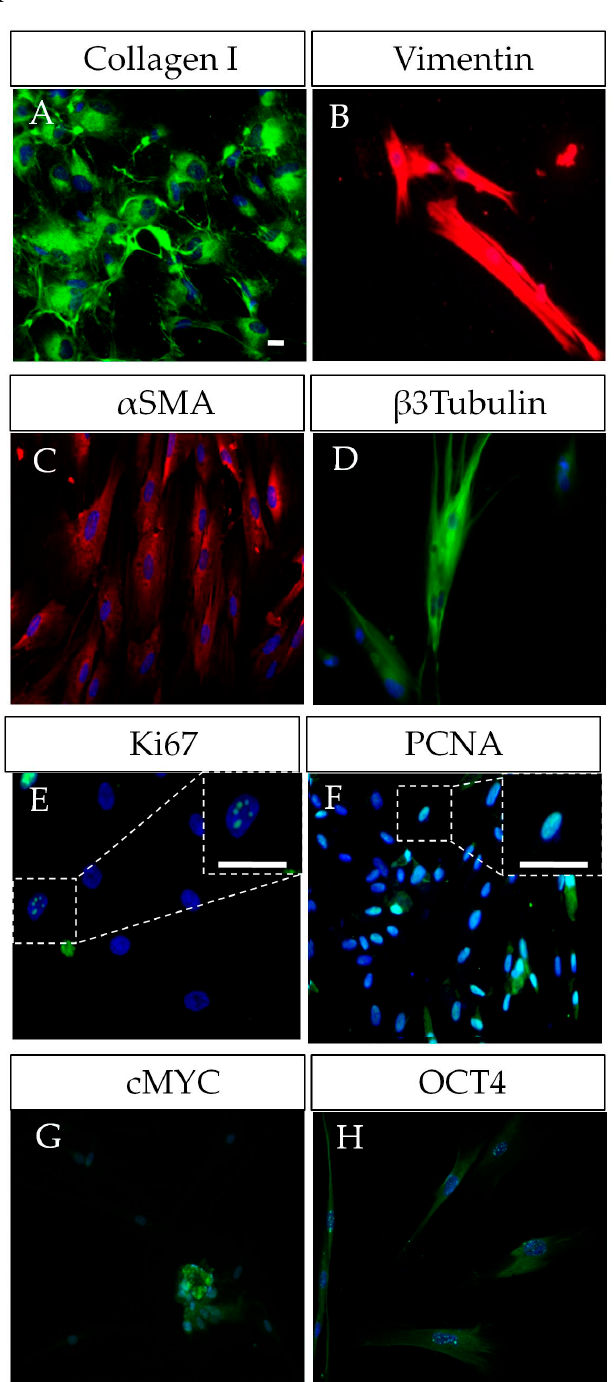
Figure 1. Characterization of human DPSCs in vitro. ( A – D ) DPSCs grown in plastic-adherent conditions show a co-expression of mesenchymal markers (COLLAGEN I, VIMENTIN, α -SMA) and neural markers ( β -III-TUBULIN/TUJ1, NESTIN), this duality reflecting their neural crest origin. ( E – H ) DPSCs as proliferative cells also show expression of Ki67 and PCNA, and even of some pluripotency core factors such as OCT4 and CMYC, SOX2. Scale bars = 20 μ m.